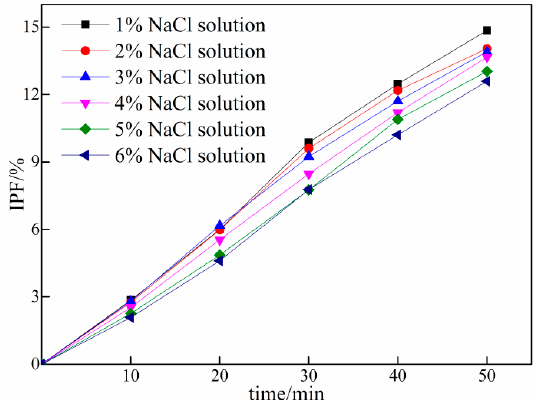
Figure 6. Relationship between ice packing fraction (IPF) and ice-making time at different initial NaCl concentrations.